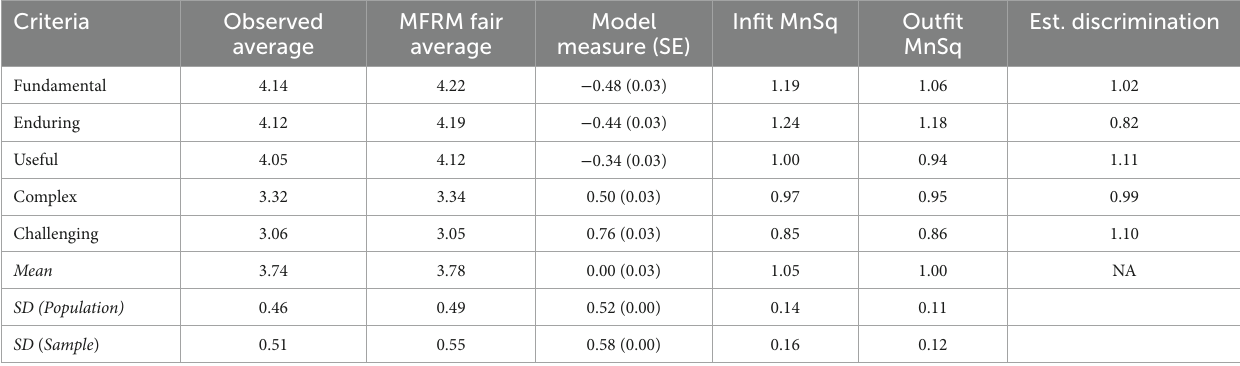
TABLE 3 MFRM analysis of core concepts